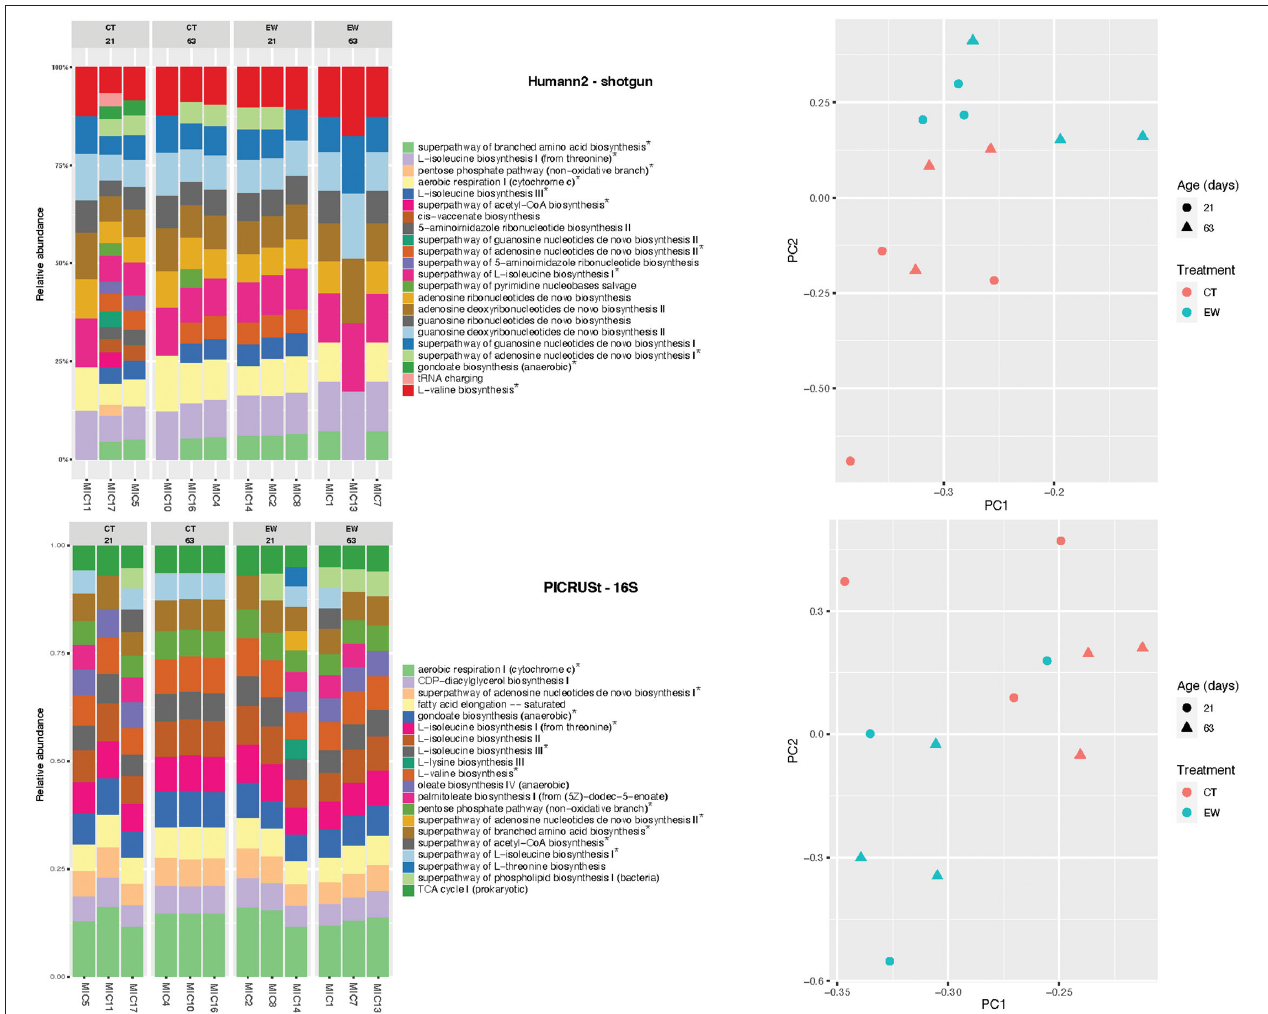
FIGURE 4 | Bacterial functional profiles inferred by Humann2 using shotgun reads and predicted by PICRUSt2 using 16S amplicons in 12 microcosms (MIC). KEGG pathways found in both analyses are marked with an asterisk. PCA of pathways are also shown for both